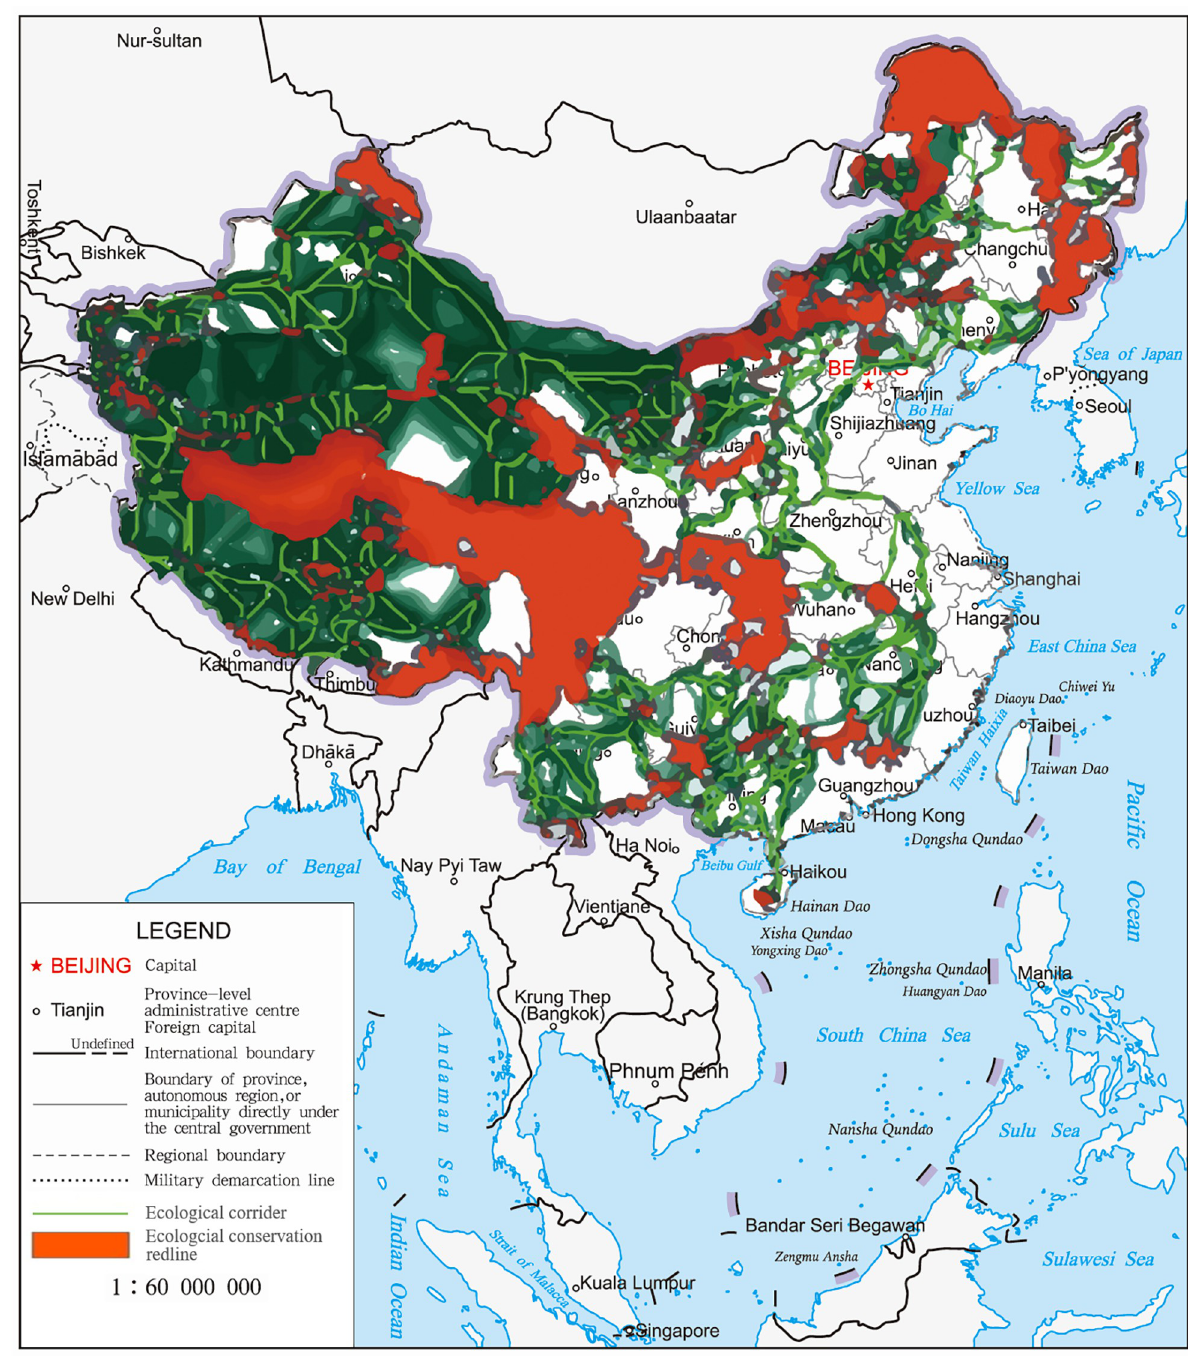
Fig 4. Diagrammatic map of national ecological corridors network based on ECR. Mongolia; (2) the intersection area of the southeastern Alxa League, Jinchang City, Wuwei City, and Zhongwei City; (3) the intersection area of the southeastern Linfen City, the western Luo- yang and Jincheng City; (4) the intersection area of Huaihua City, the western Yongzhou, and the northern Hezhou; (5) the intersection area of the eastern Changji and the southeast Hami